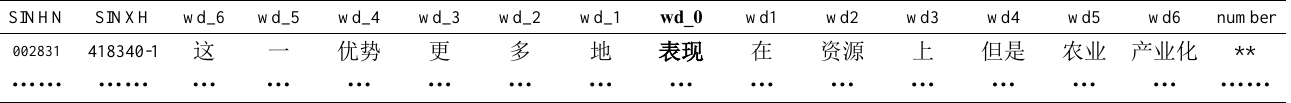
Table 3. Description of data in decision